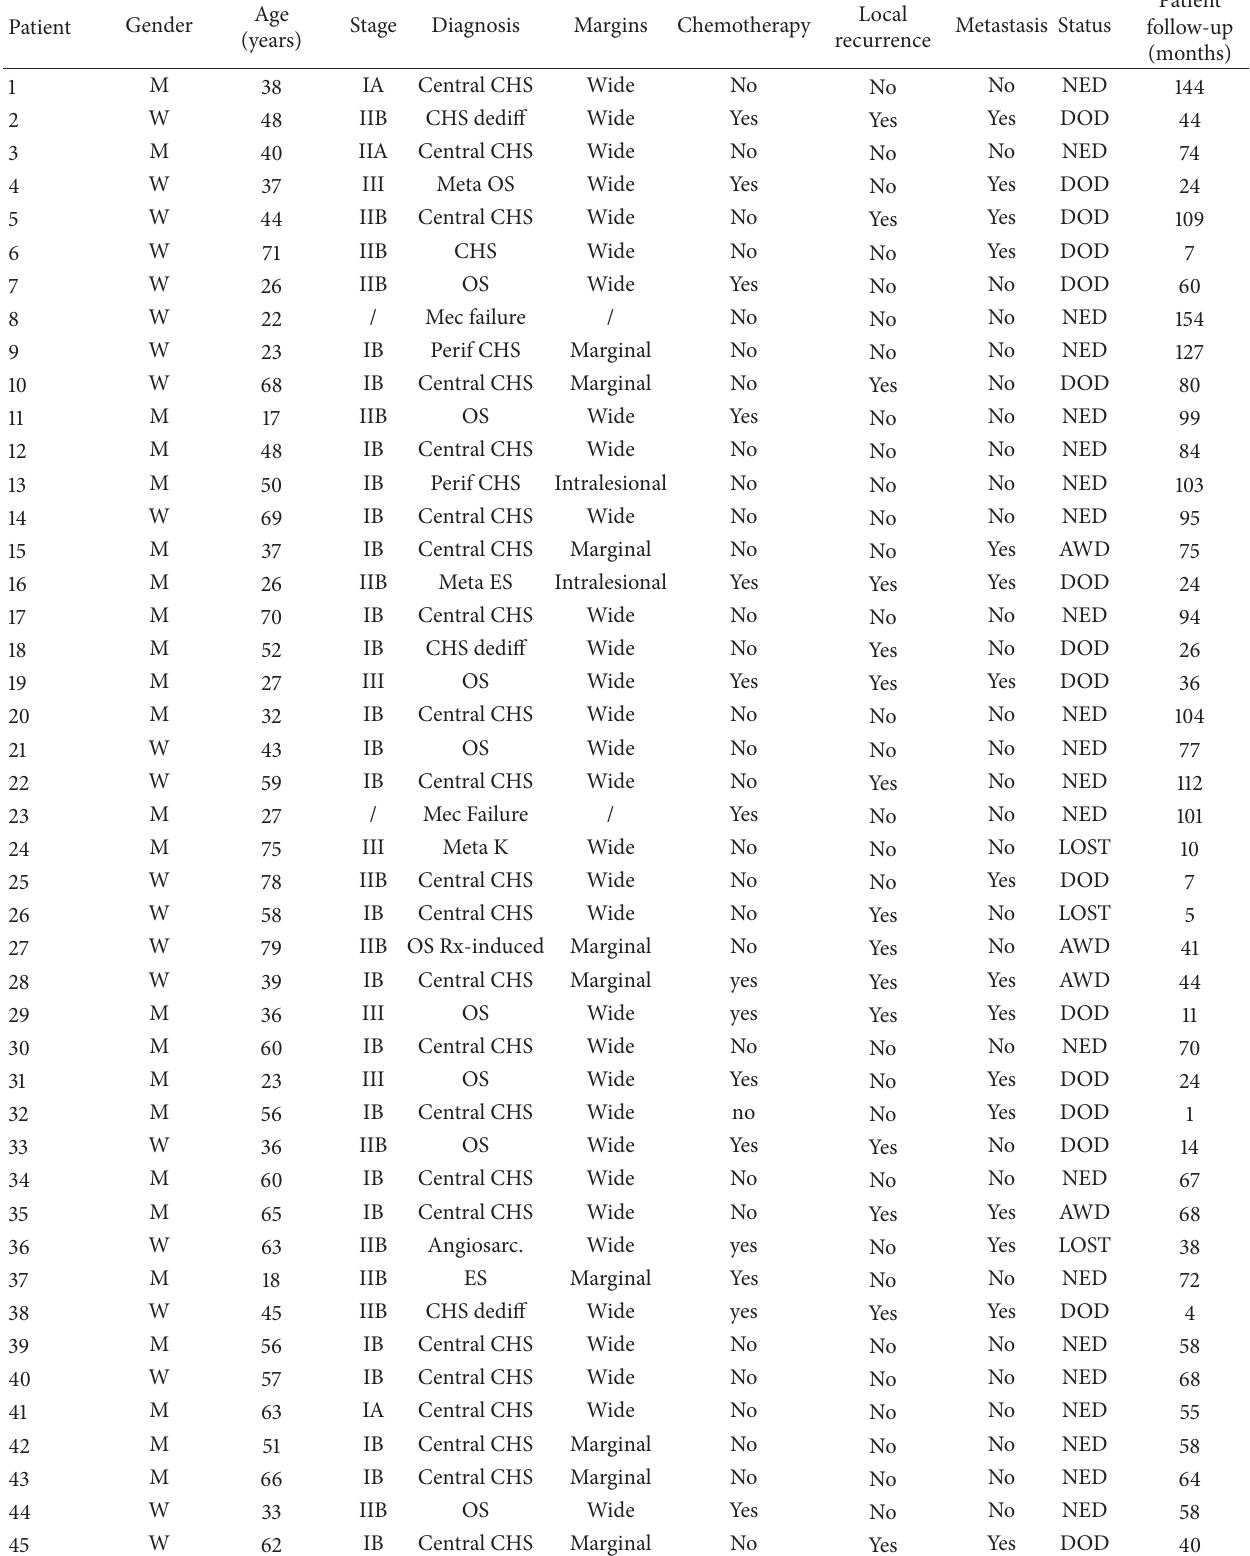
Table 1: General